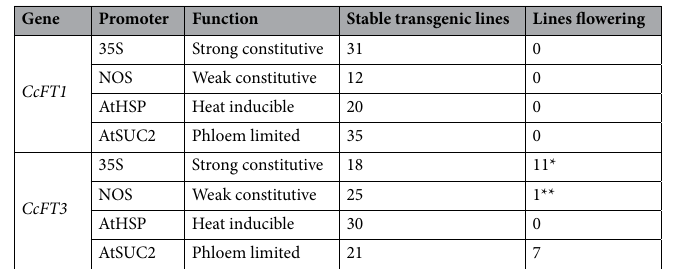
Table 1. Summary of transgenic lines produced in this study. *These lines all flowered in vitro. **Plant flowered once.